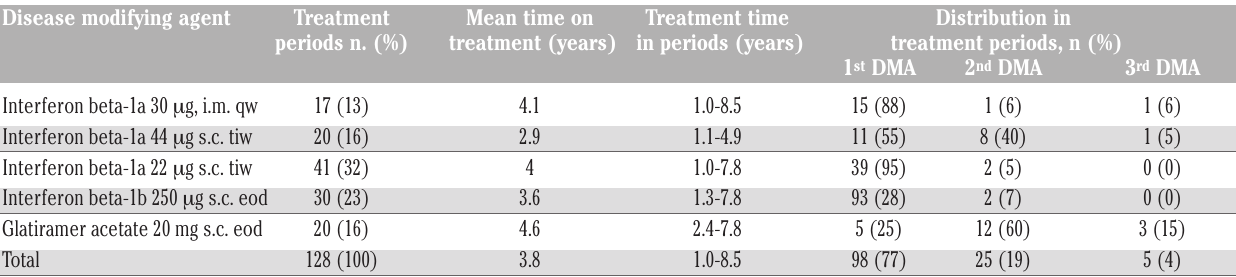
Table 1. Usage of disease modifying agents (DMAs) during the treatment periods from 2002 to 2010, distribution by consecutive treat- ment period, duration of treatment period by DMA, and treatment time in the treatment periods. Disease modifying agent Treatment Mean time on Treatment time Distribution in periods n. (%)